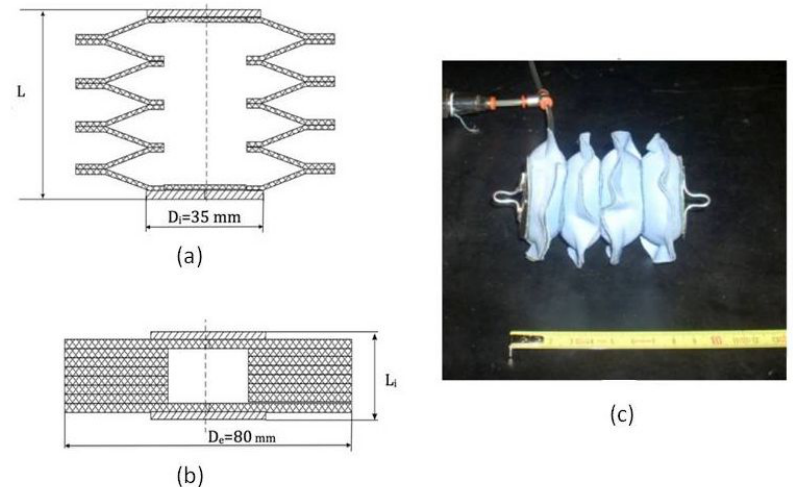
Figure 6. DIMEAS bellows type pneumatic muscle: ( a ) cross section during actuator work; ( b ) cross section at rest; ( c ) pressurized actuator.